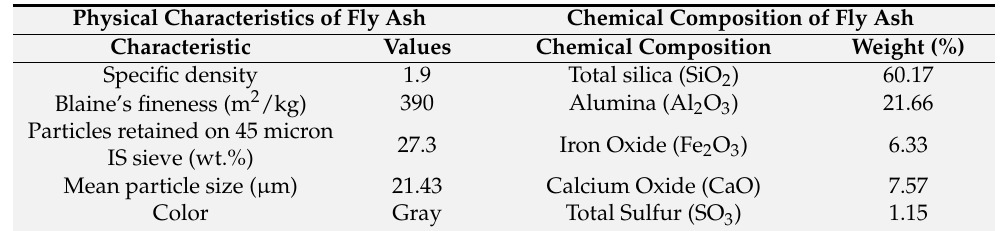
Table 1. Characteristics of fly ash.